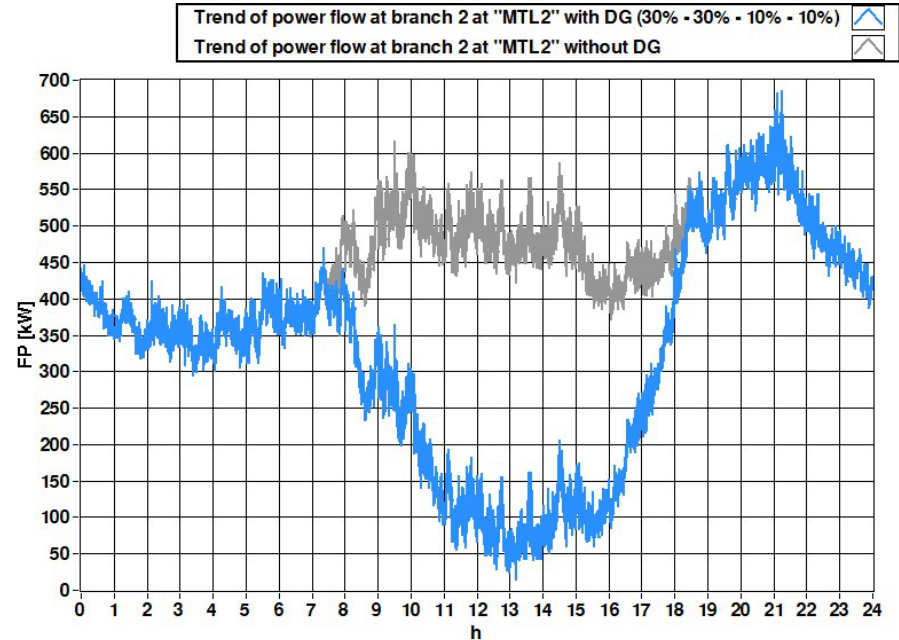
Figure 26. Active power flow during the day 31 May 2018 in branch 2 of the “MTL2” line, both in the absence and with the DG power injection corresponding to Scenario 4.